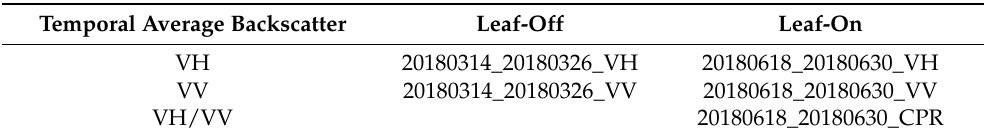
Table 2. Summary of the Sentinel-1 temporal average backscatter parameters of the 2018 vegetation period used for classification.